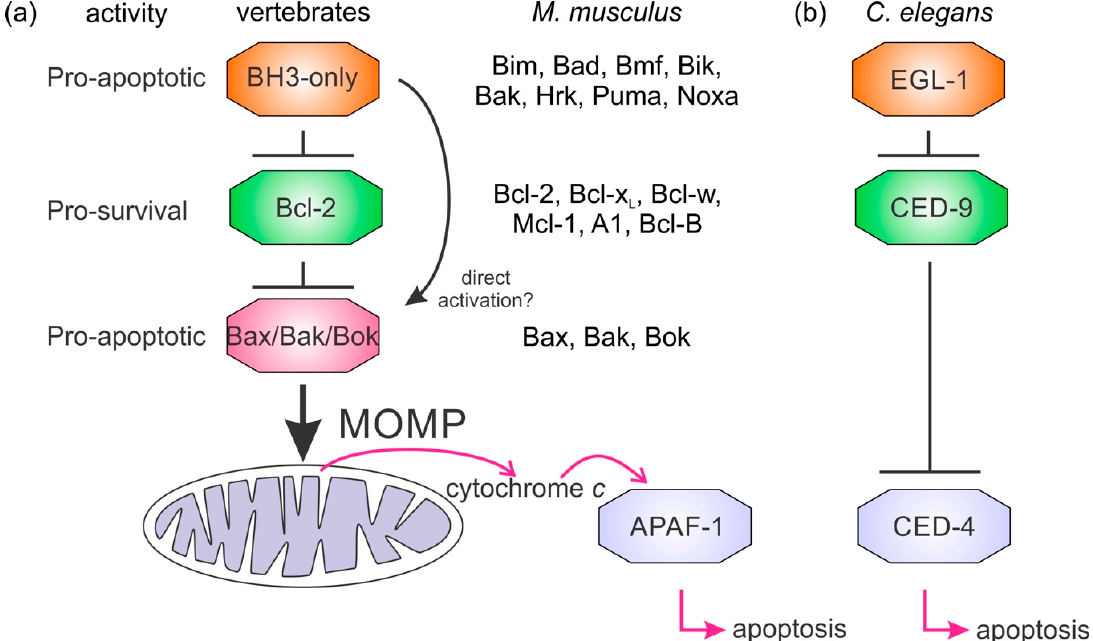
Figure 1. Mechanisms of Bcl-2 regulated apoptosis. Simplified apoptosis schemes showing the role of Bcl-2 proteins in apoptosis initiation differ between mammals ( a ) and nematodes ( b ). The Bcl-2 family members are indicated for M. musculus. Nematodes have a simplified activation of apoptosis where the BH3-only protein EGL–1 binds the sole prosurvival protein in the C. elegans genome CED-9. This event